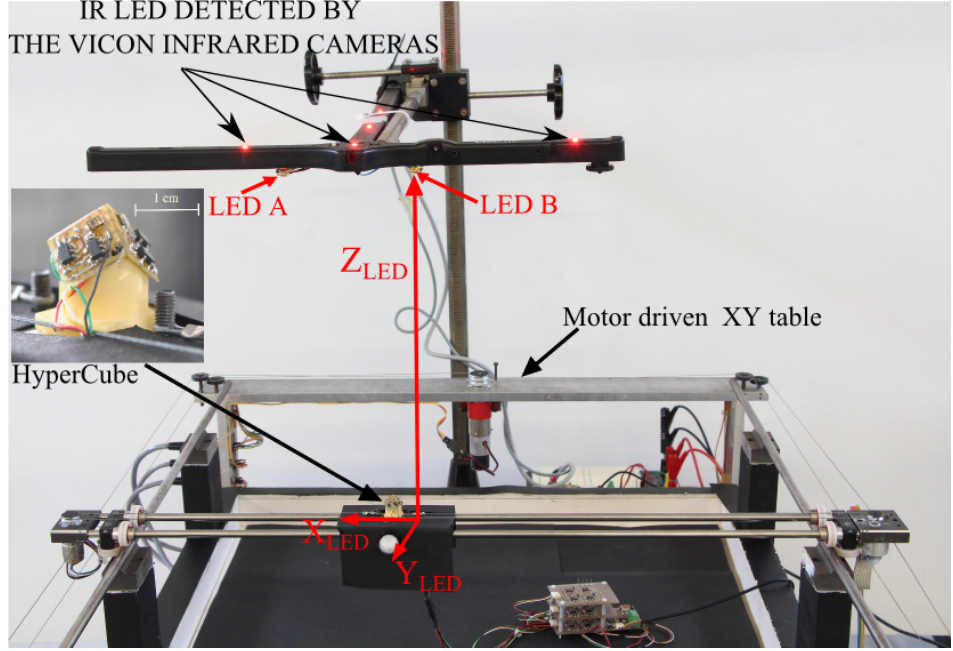
Figure 10. XY table driven by DC motors. The HyperCube position is controlled in closed-loop by means of two incremental encoders. The distance Z here to be known and constant. Additional active motion markers were used to compare the precision of HyperCube with the ground truth acquired from the VICON motion capture system.